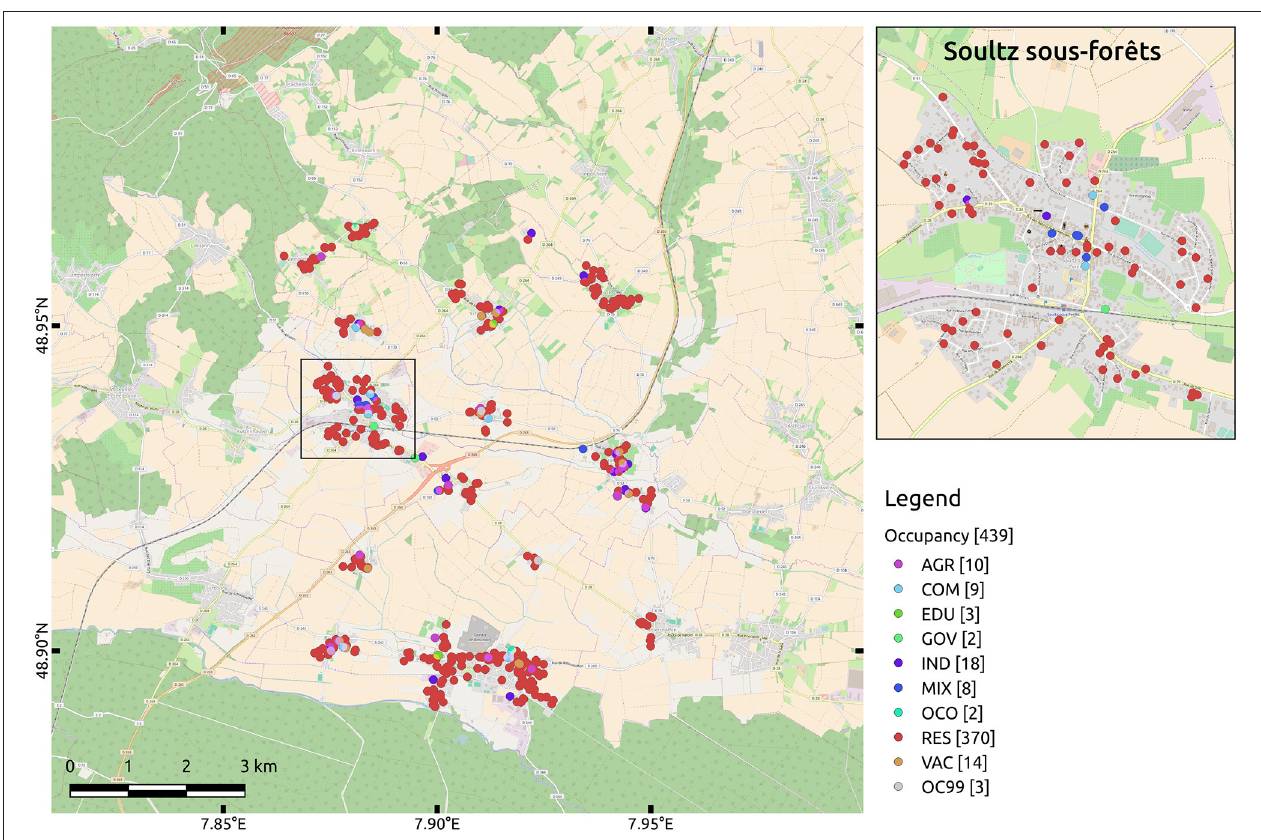
FIGURE 2 | Geographical distribution of the surveyed buildings. As can be noted by the observed occupancy (color-coded), most are residential structures.